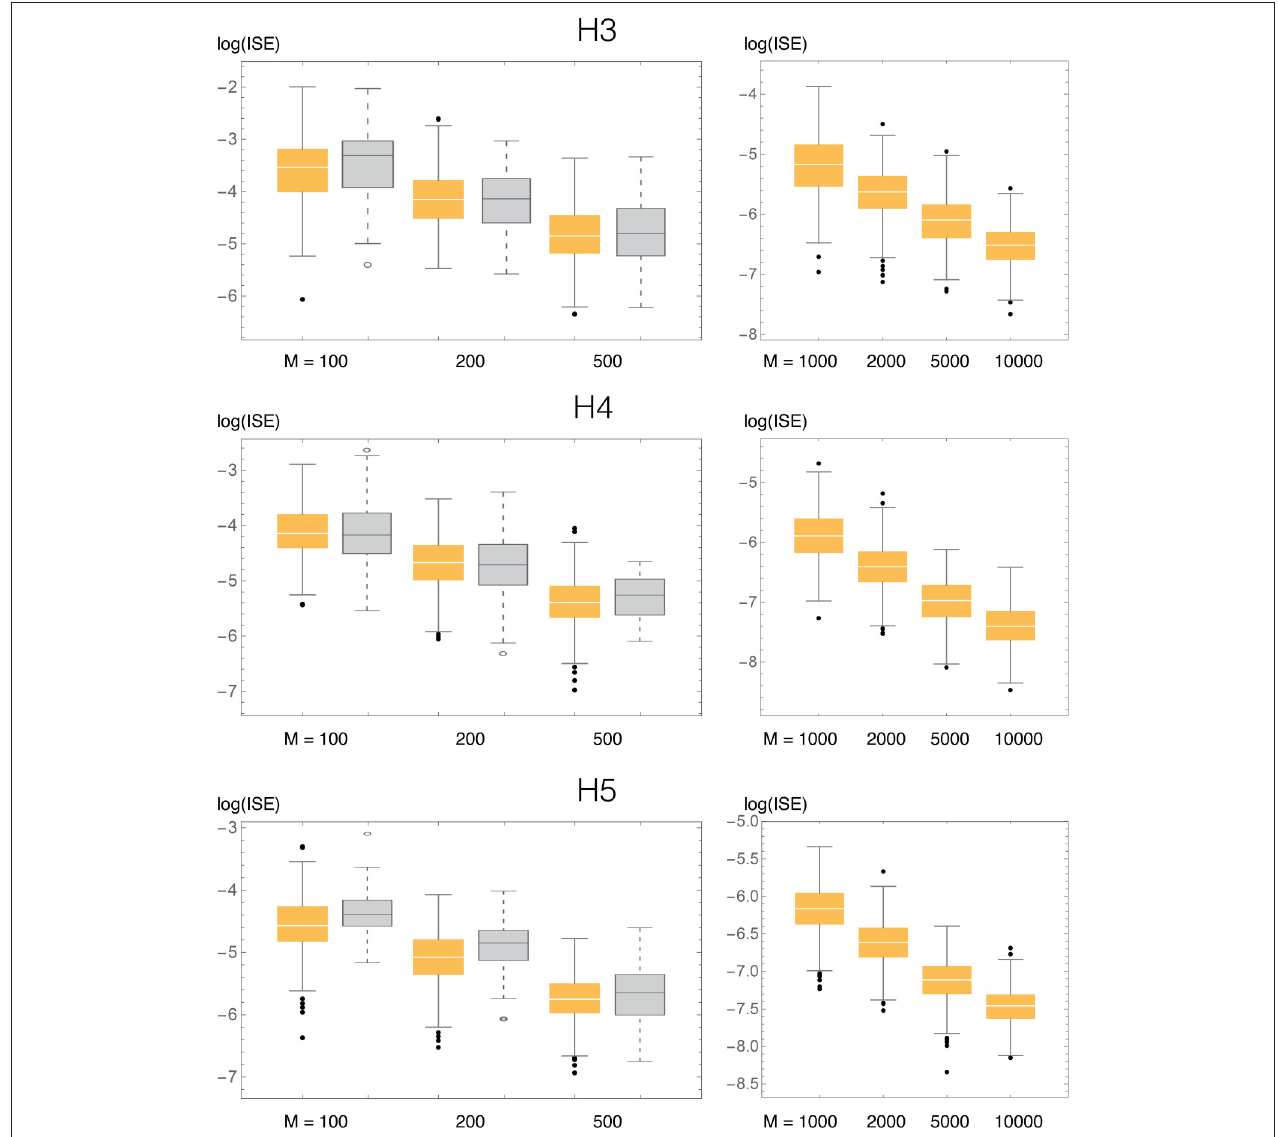
FIGURE 5 | ISE statistics for the three univariate test densities (H3, H4, H5), compaing our method (BADE, in orange) and VB3 (Hazelton, 2003, in gray). Also shown are results for larger values of the sample size M , not considered by